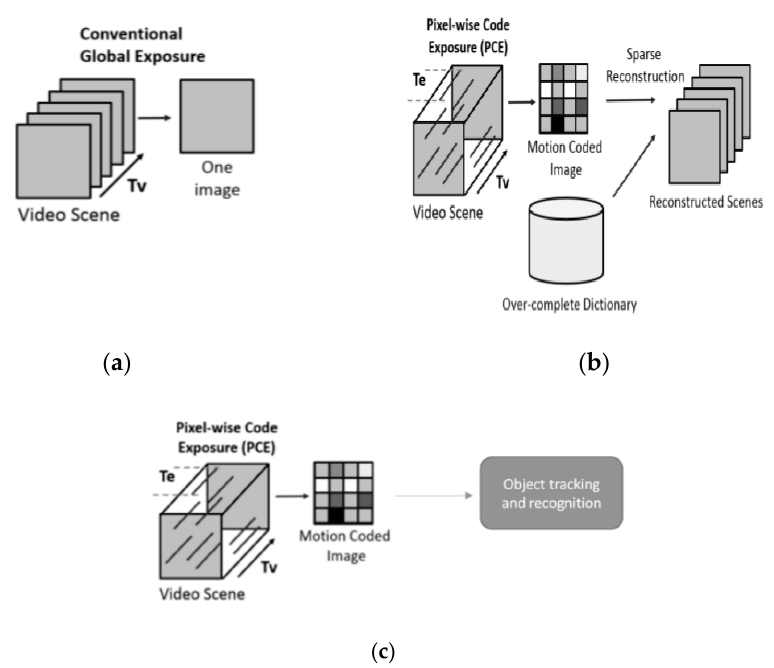
Figure 1. ( a ) Conventional camera; ( b ) Pixel-wise Coded Exposure (PCE) compressed image/video sensor [11] with image reconstruction; ( c ) proposed direct object detection and classification scheme without image reconstruction.